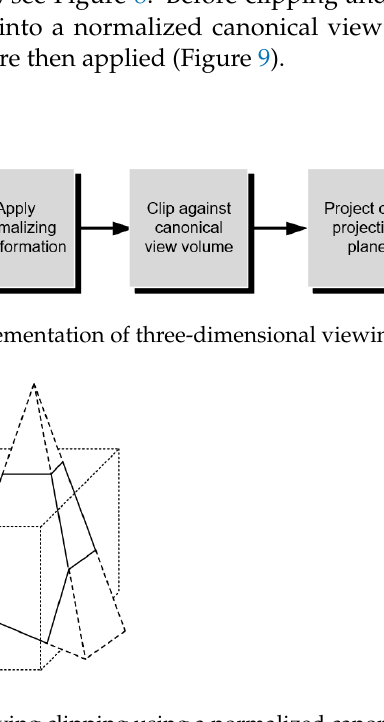
Figure 9. Applying clipping using a normalized canonical clipping